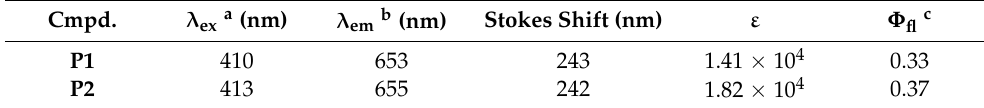
Table 1. The absorption wavelength, emission wavelength, and Stokes shift of probes. Cmpd. λ ex a (nm) λ em b (nm) Stokes Shift (nm) ε Φ fl c P1 410 653 243 1.41 × 10 4 0.33 P2 413 655 242 1.82 × 10 4